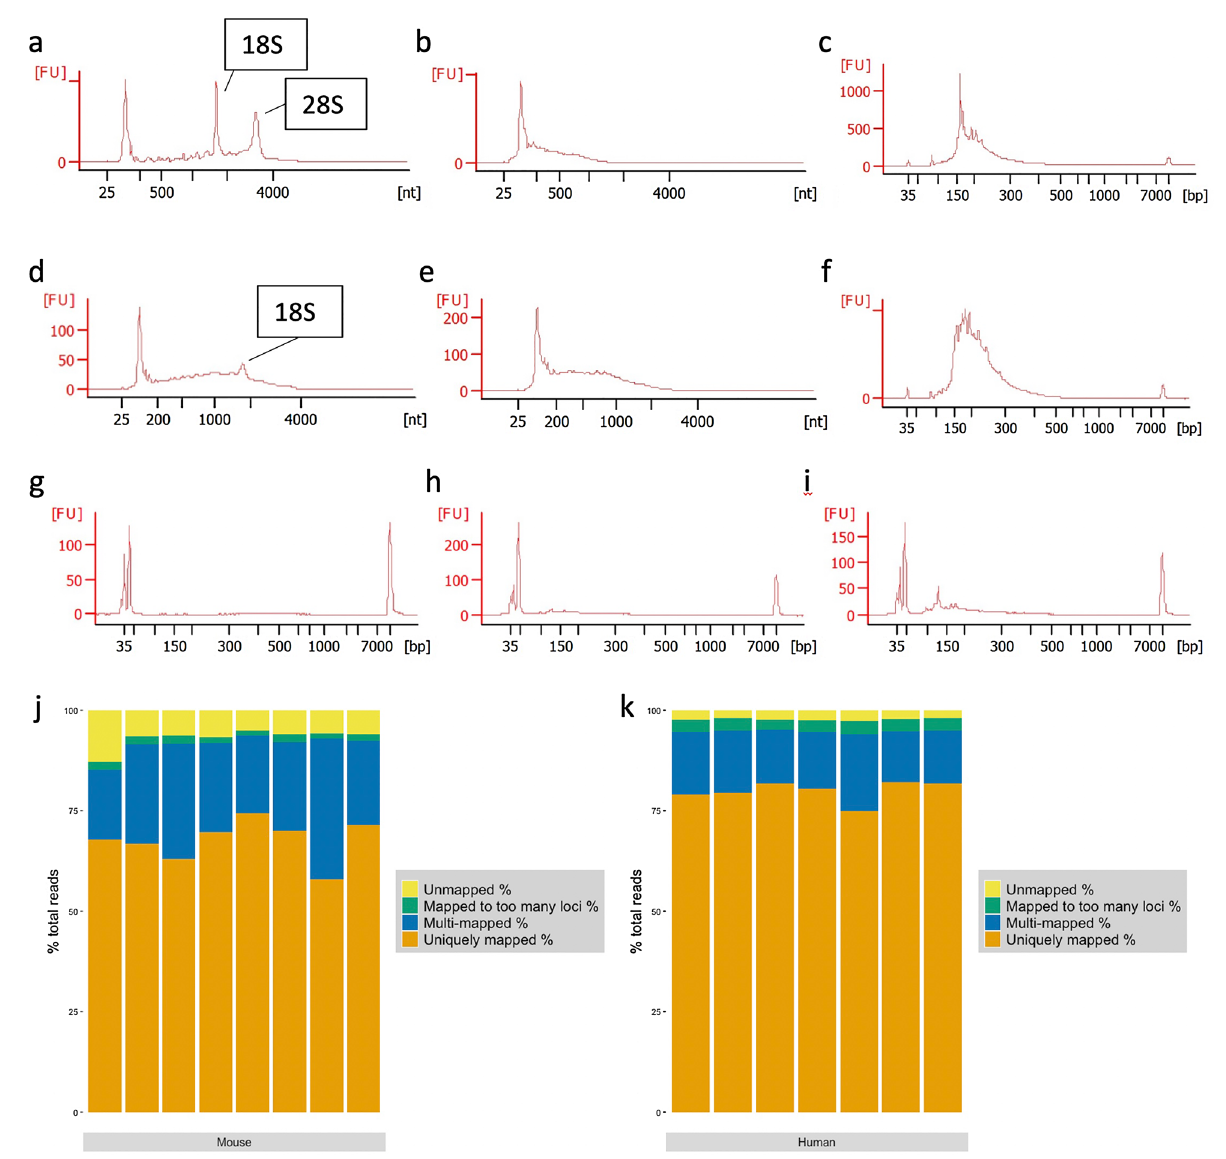
Representative Bioanalyzer electropherograms of (d) total input RNA, (e) RNA after 1 min fragmentation by RNase III, and (f) final amplified cDNA library from human MTG RNA. ( g–i ) Representative Bioanalyzer electropherograms of unamplified cDNA produced from adapter ligation for ( g ) 30 min at 30 °C ( h ) 60 min at 30 °C, and ( i ) 16 h at 16 °C. Yield of cDNA (size 50 to 1000 bp) markedly increases from 53 pg/μL ( g ) to 528 pg/ μL ( h ) to 745.5 pg/μL ( i ) with increasing ligation time. ( j ) RNA reads mapped to the ENSEMBL Mus musculus GRCm38.95 annotated genome and ( k ) to the ENSEMBL Homo sapiens GRCh38.96 annotated genome. Uniquely mapped reads, multi-mapped reads, reads mapped to too many loci (> 10), and unmapped reads for each sample shown as a percentage of total trimmed and filtered